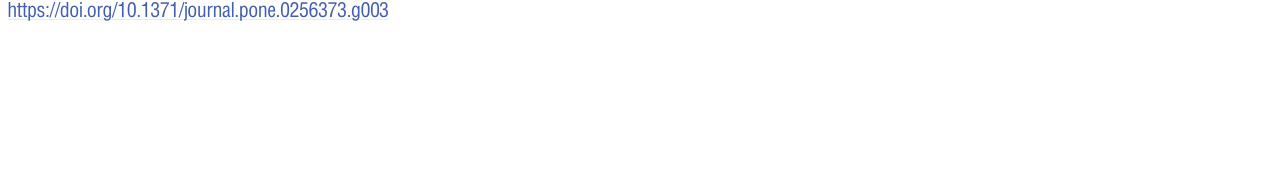
PLOS ONE | https://doi.org/10.1371/journal.pone.0256373 August 24, 2021 8 /